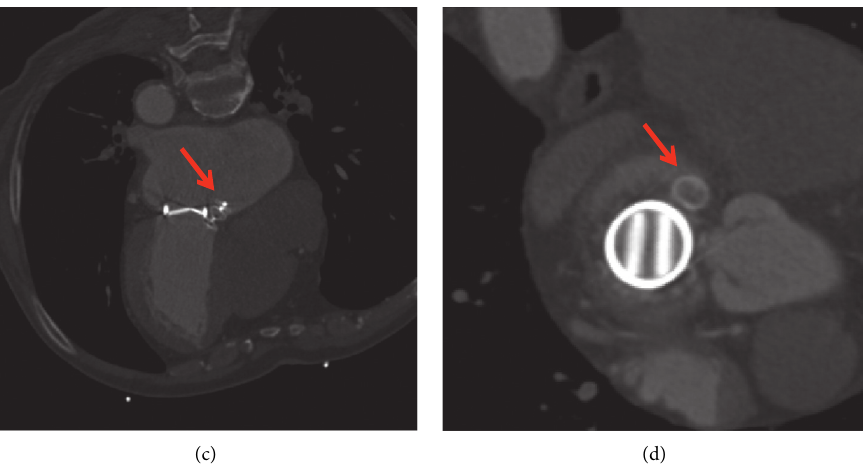
Figure 7: The 3-dimensional echocardiograms and computed tomography angiograms taken before the procedure and during the follow-up period. (a) Three-dimensional transesophageal echocardiography shows the mitral paravalvular leak (PVL) before the procedure. (b) Three- dimensional transesophageal echocardiography shows the mitral PVL closed with the occluder. (c) The mitral PVL was closed with the occluder (sagittal view). (d) The mitral PVL was closed with the occluder (axial view). The yellow arrow indicates the PVL. The red arrow indicates the